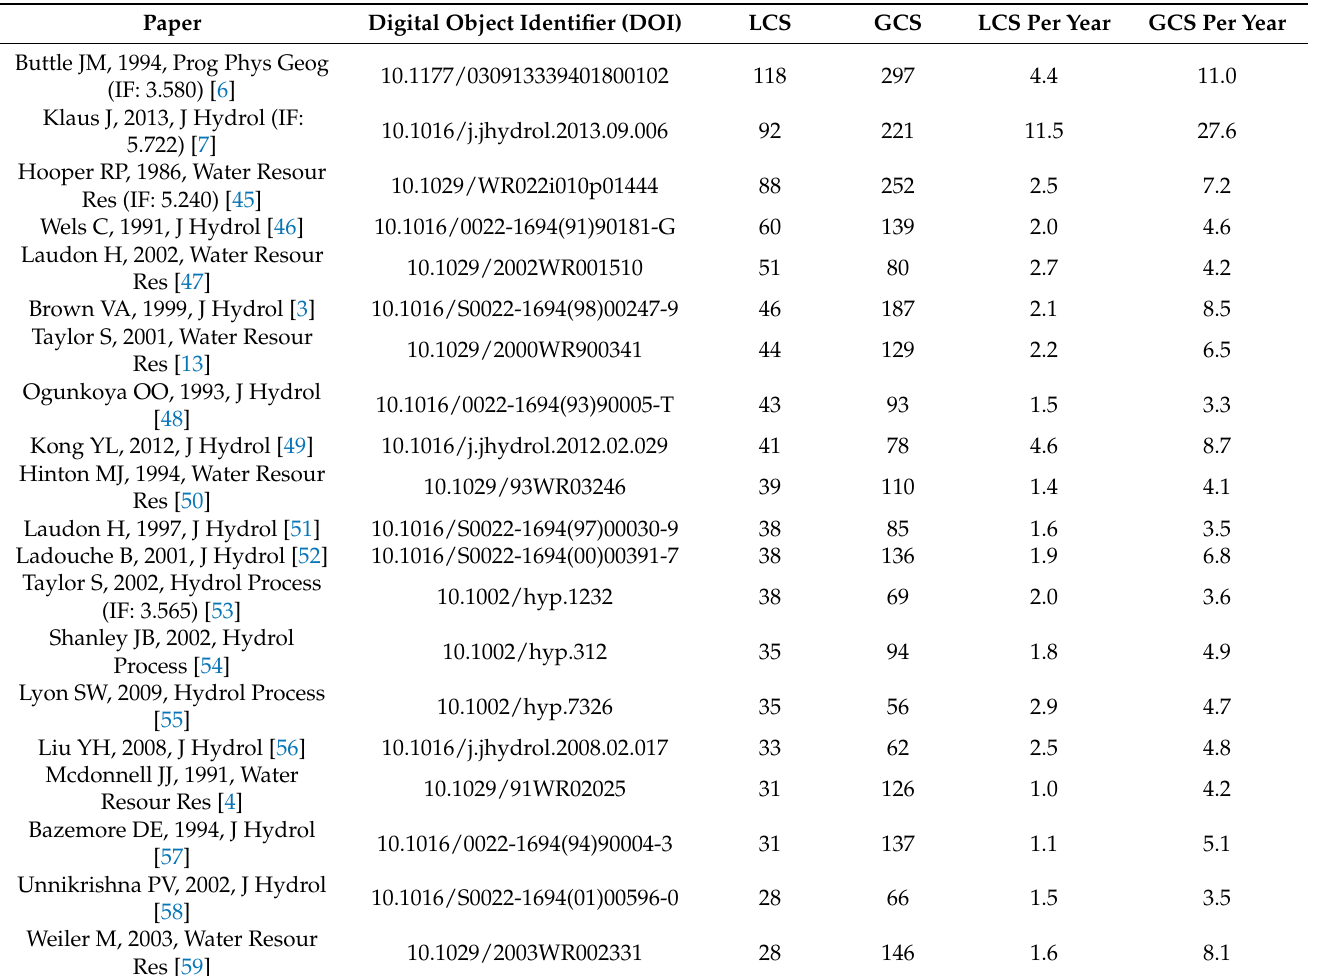
Table 3. Twenty most influential papers based on